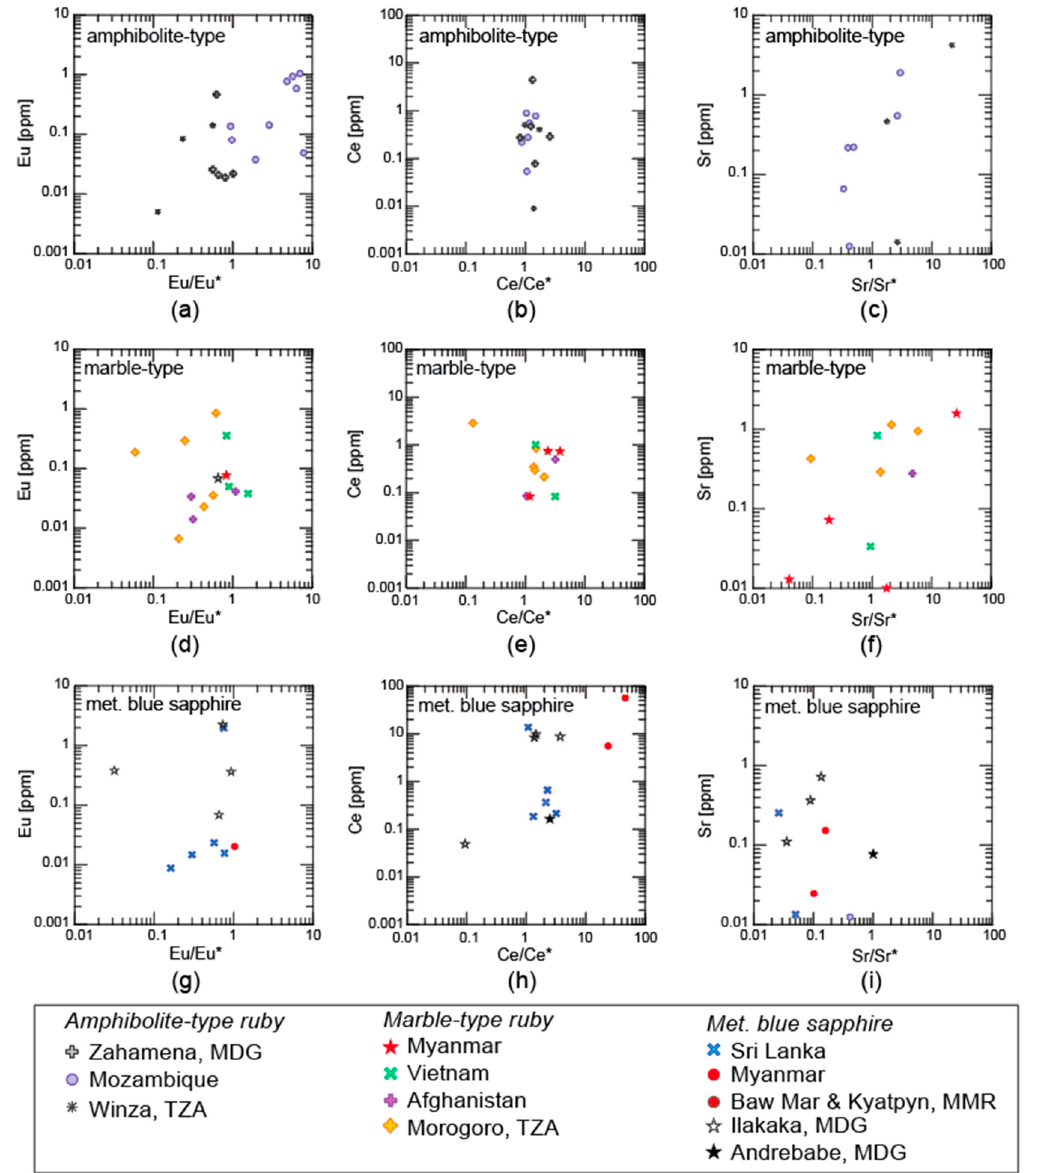
Figure 4. Primitive mantle-normalized [58] trace element compositions in gem corundum ablated offine in this study. Points represent individual analyses. ( a – c ) Eu versus Eu/Eu*, ( d – f ) Ce versus Ce/Ce*, and ( g – i ) Sr versus Sr/Sr*. Anomalies were calculated using Eu/Eu* = 2 × Eu N /(Sm + Gd) N , Ce/Ce* = Ce N /((La N ) 0.667 × (Nd N ) 0.333 ), and Sr/Sr* = 2 × Sr/(Ce + Nd), where N indicates normalization to average primitive mantle values of [58]. MNR, Myanmar.